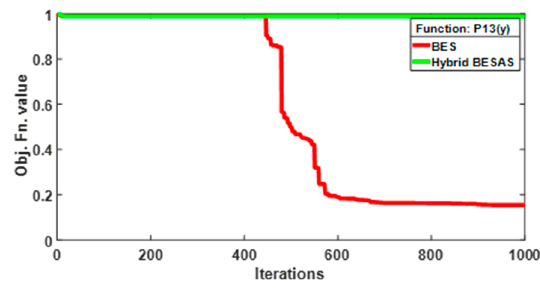
Figure 6. Convergence profile for function 𝑝 (cid:2869)(cid:2871) .